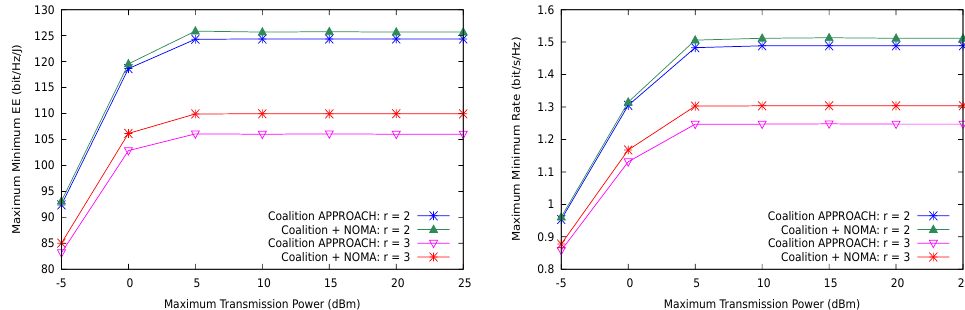
Figure 4. EE mmf and max-min rate for the shared CUs case using DL clustering.